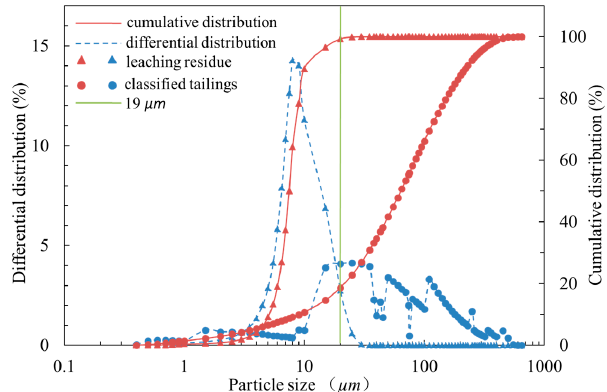
Figure 1. Particle size grading of leaching residue and classified tailings.